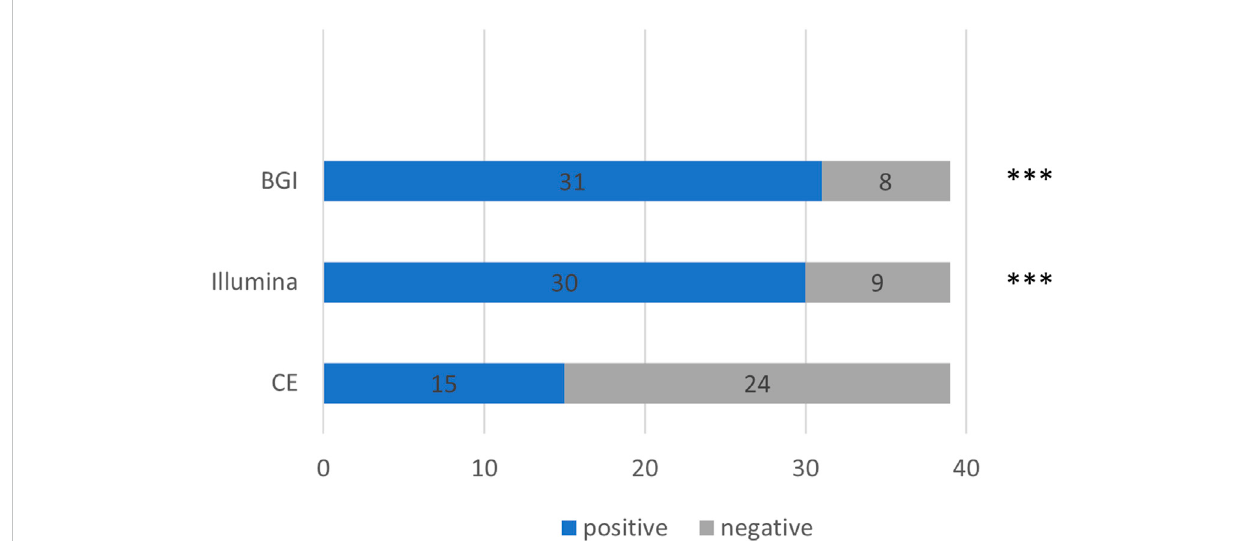
FIGURE 4 Comparison between thepathogenic detection ratesofCE and themNGSplatforms (Illumina and BGI). *** p < 0.001, compared with CE.The x -axis represents the number of cases, while the y -axis represents the detection methods. CE, conventional examinations.